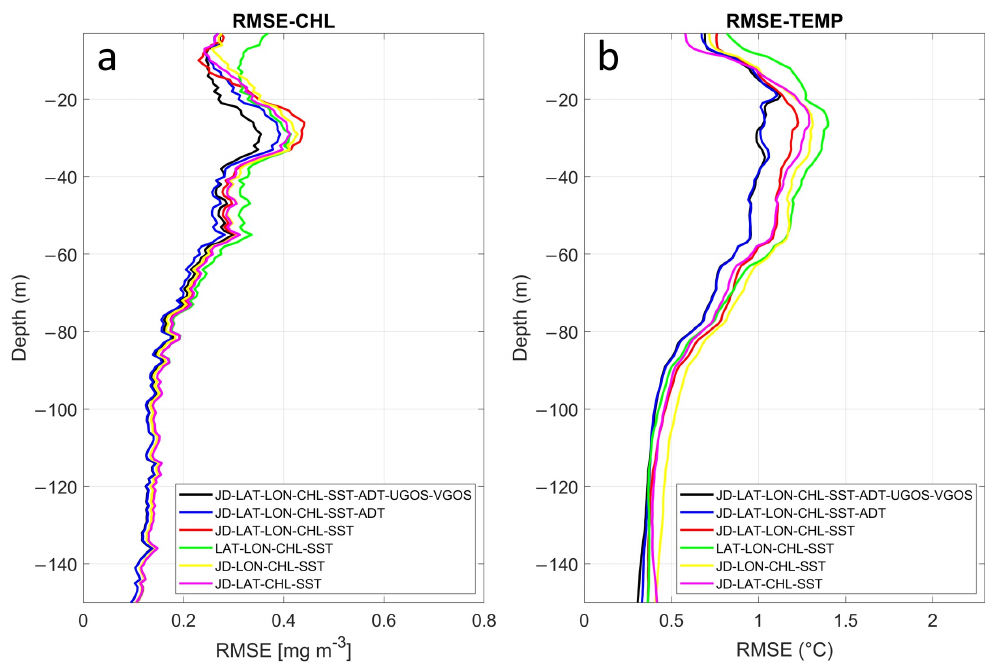
Figure 9. Sensitivity analysis results for the test dataset. Left panel ( a ) shows chlorophyll RMSE as a function of the depth, resulting from the use of di ff erent input combinations; the right panel ( b ) shows the same for temperature. The multiple inputs combinations are colored and reported in the